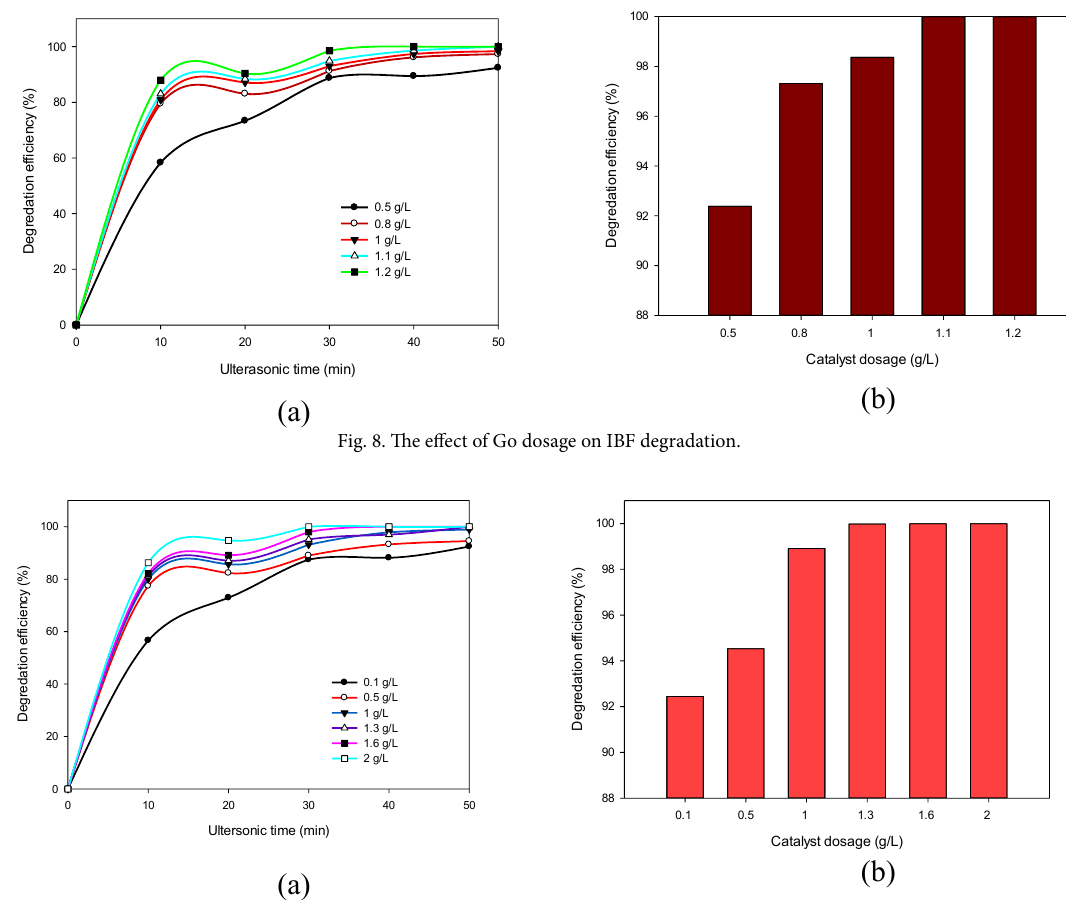
Fig. 9. The effect of Pd NPs dosage on IBF degradation.